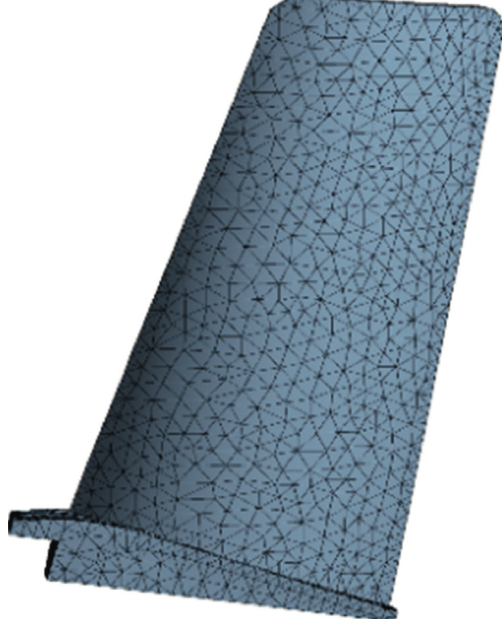
Figure 2: FE model of turbine